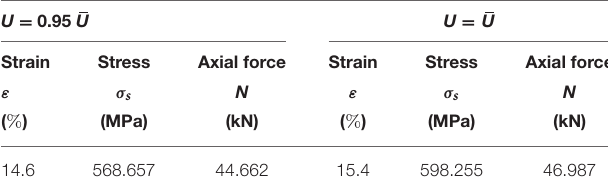
TABLE 3 | Strain, stress and axial force carried by the generic perimeter string in U ) configurations. the almost fully-flat ( U 0.95 U ) and fully-flat ( U = =